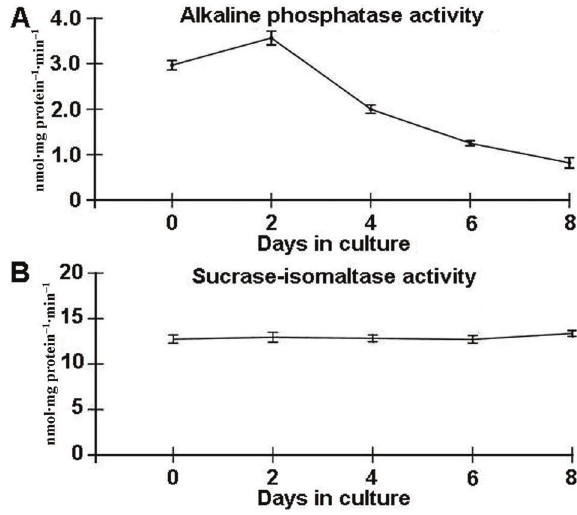
Figure 5. Detection of intestinal brush border enzymes activity in mouse intestinal epithelial cells (IECs). Alkaline phosphatase ( A ) and sucrase-isomaltase ( B ) speci fi c activity in mouse IECs were measured during 8 days of culture. All samples were tested in triplicate. Activity values are reported as means ± SD.